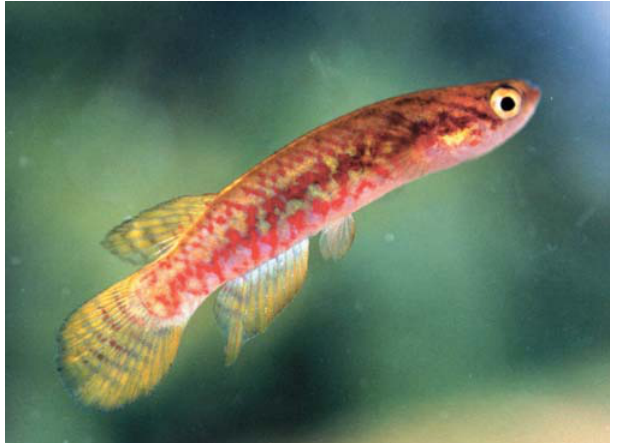
Fig. 6. Rivulus litteratus , UFRJ 5956, male, holotype, 26.9 mm